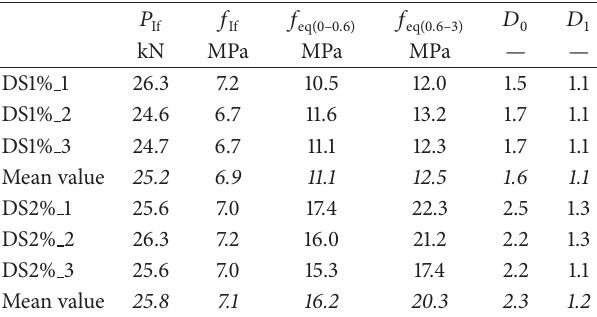
Table 7: Four-point bending tests: tensile strength